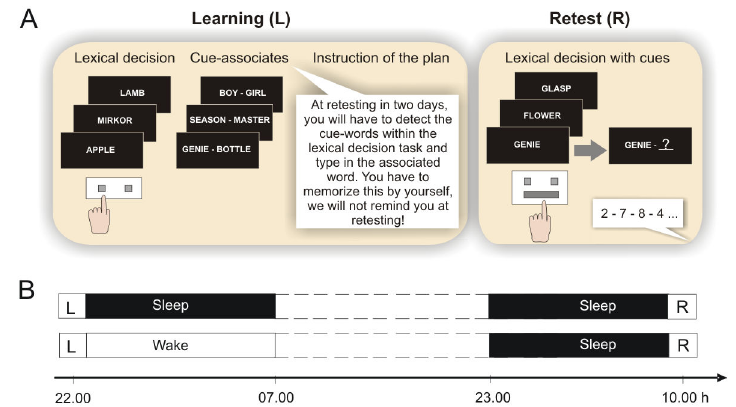
Figure 1. Prospective memory task and experimental design. (A) During learning, subjects practiced on the lexical decision task first, which required them to press one of two buttons indicating whether the presented word was a real word or not. Thereafter, subjects learned 20 cue–associate word pairs. For instruction of prospective memory, subjects were then told that at retesting on the lexical decision task two days later, some of the 20 cue words could occur within this task and if they detected a cue word they should press the 'space' bar and type in the respective associated word. Subjects were explicitly told that they need to memorize this instruction because the experimenter would not remind them of what to do at retesting. In order to manipulate available attentional resources, subjects performed at retesting in parallel a secondary task (monitoring spoken digits for two consecutive even digits) either during the first or second half of the lexical decision task. (B) Experimental design: Learning (L) took place in the evening (~22.00 h) followed by a night of sleep (sleep group) or wakefulness (wake group). Retrieval (R) was tested after another night of (recovery) sleep in both